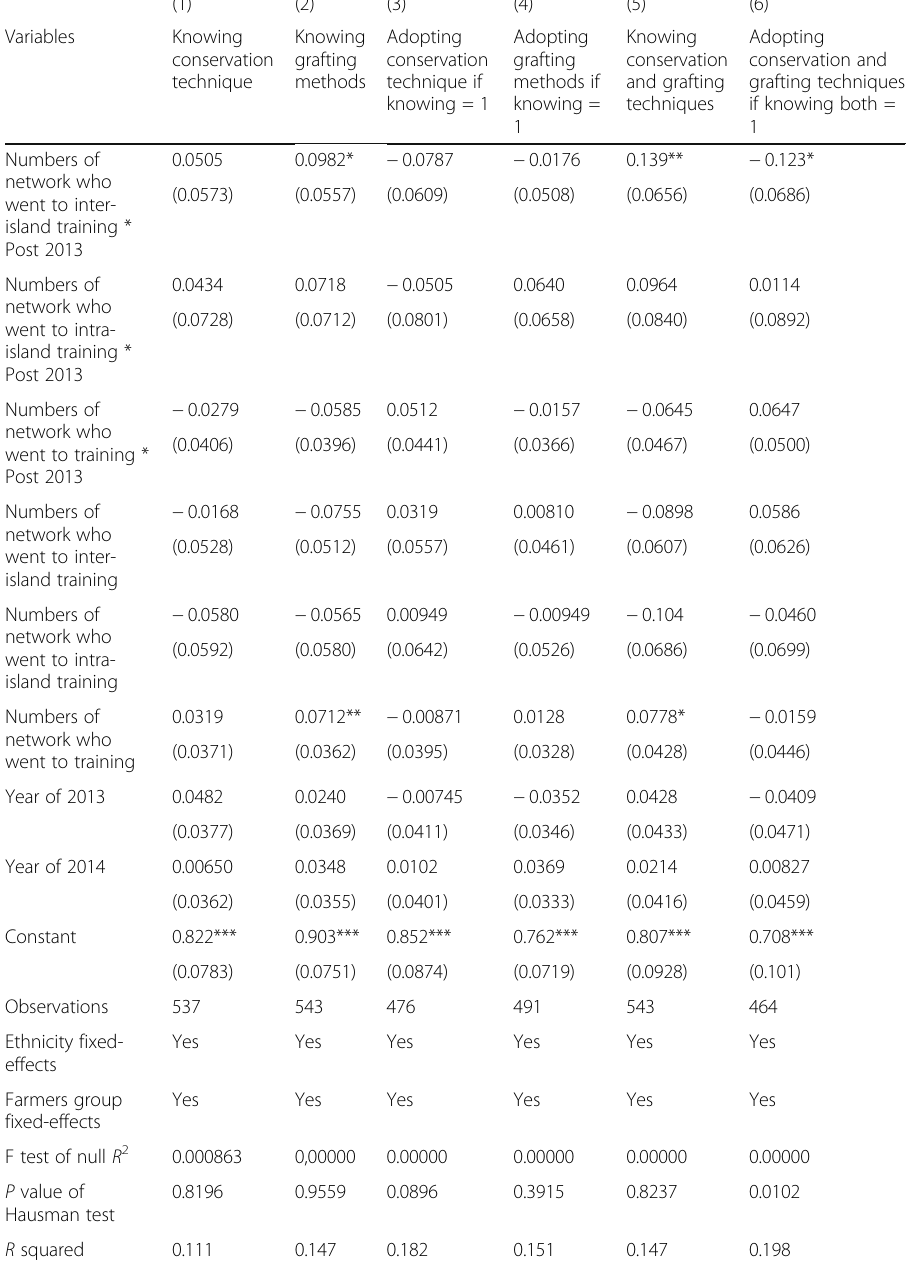
Table 7 Effects of locational heterogeneity of training on information spillover on non-training